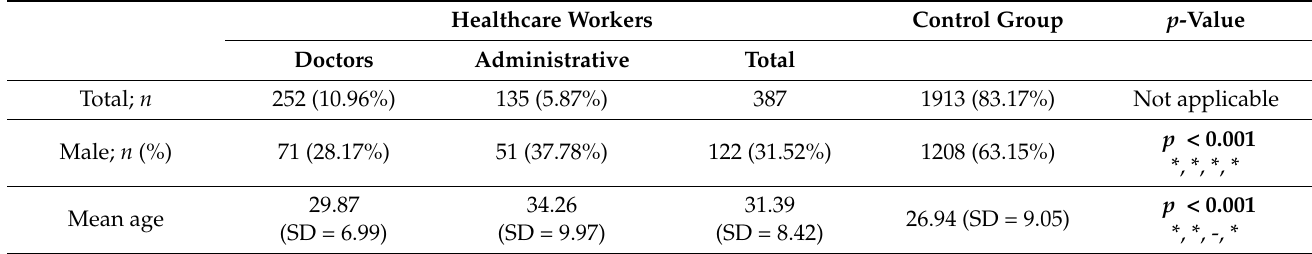
Table 1. Study and control group characteristics ( n = 2300).